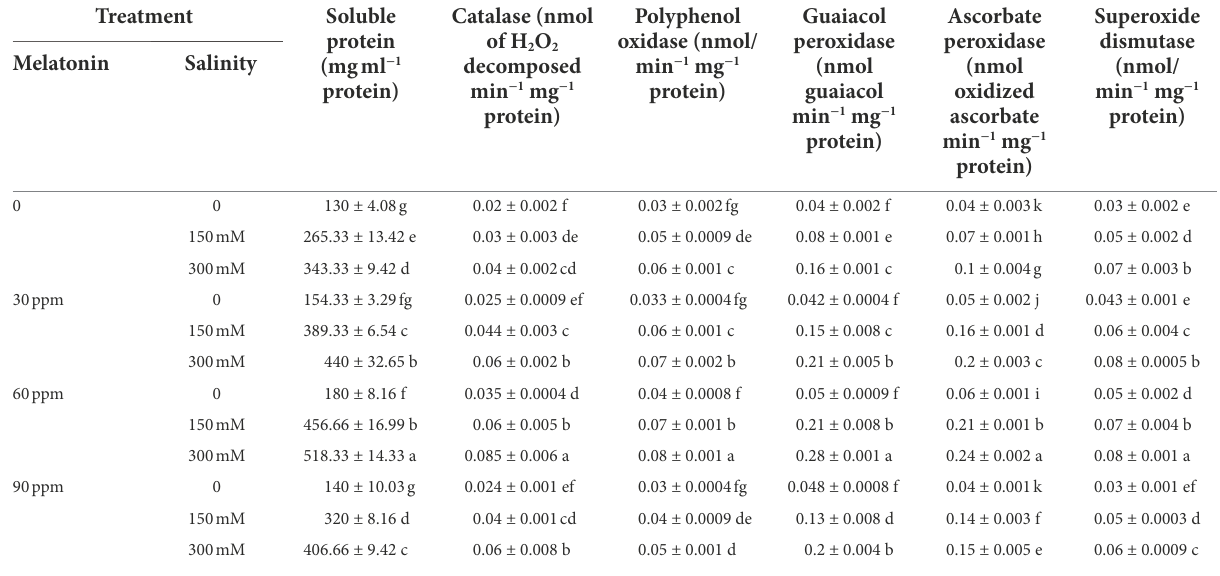
TABLE 2 The mean comparison effects of melatonin concentrations and different levels of NaCl on soluble protein content and antioxidant enzyme